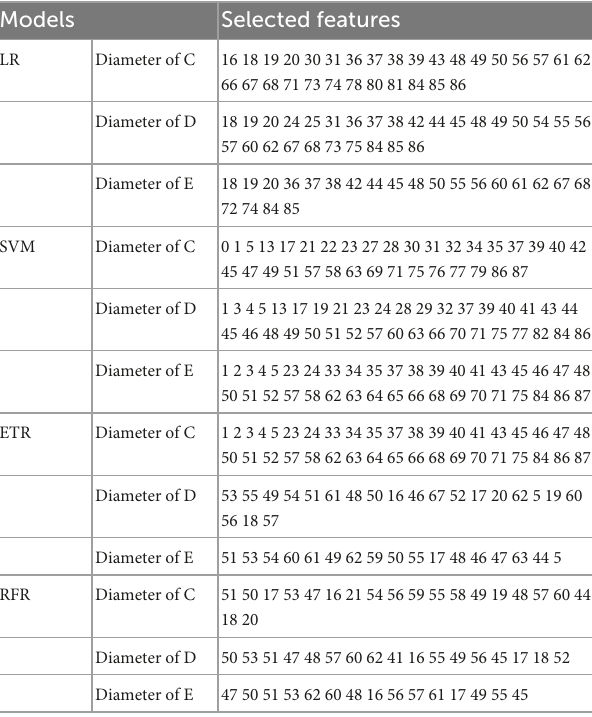
TABLE 4 Selected features of different models. Models Selected features